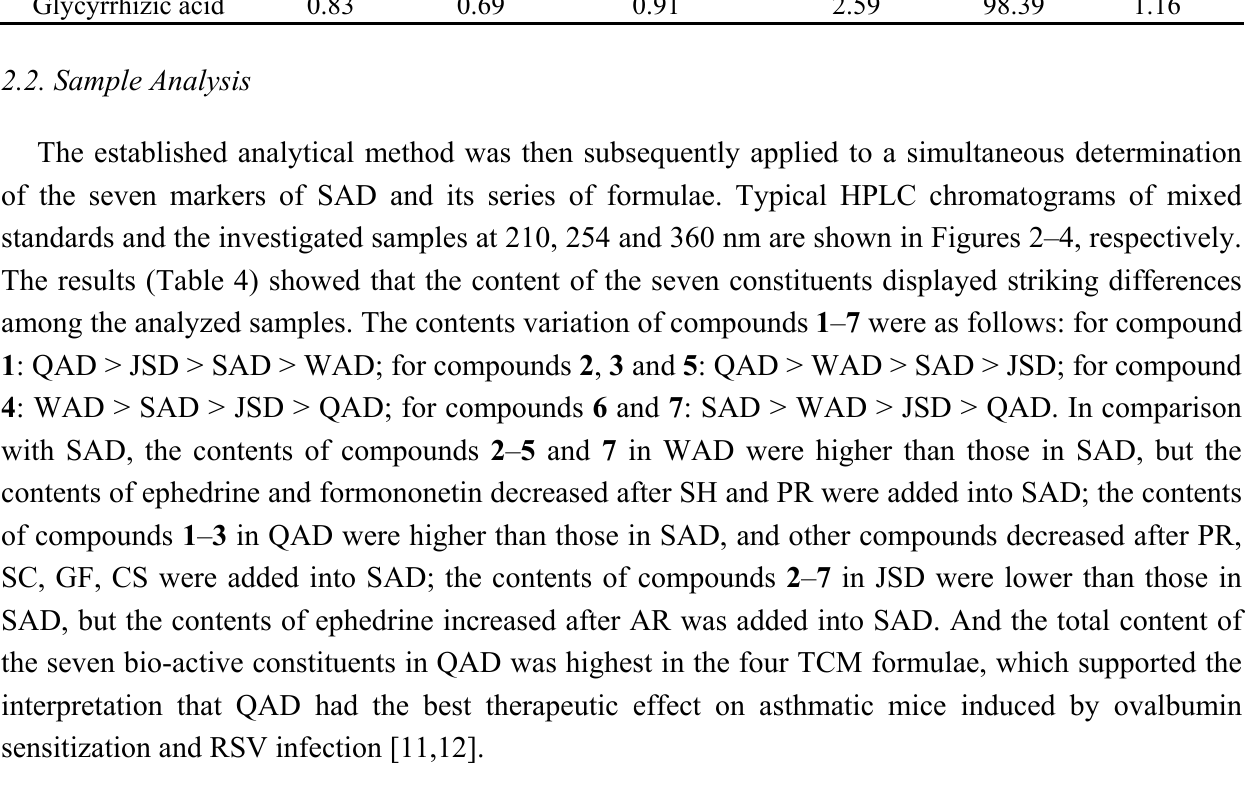
Figure 2. Typical HPLC chromatograms of mixed standards and the investigated samples at 210 nm. ephedrine ( 1 ), amygdalin ( 2 ), liquiritin ( 3 ), benzoic acid ( 4 ), isoliquiritin ( 5 ), formononetin ( 6 ) and glycyrrhizic acid ( 7